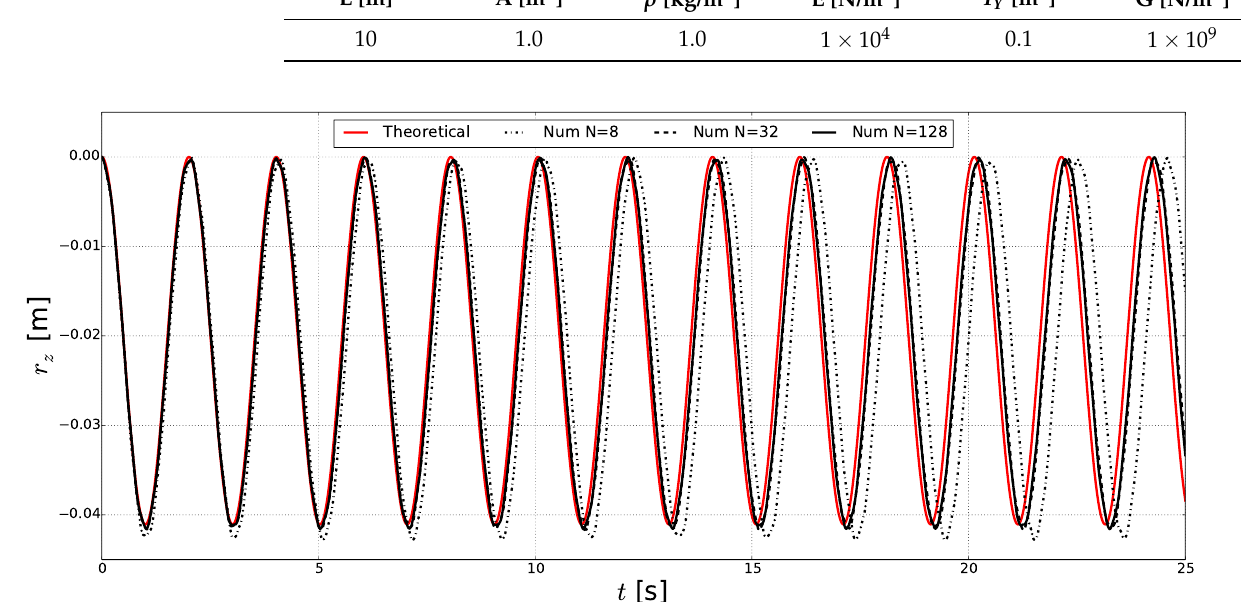
Figure 5. Comparison of the numerical and theoretical solutions for the vibration of a pinned rod under static force